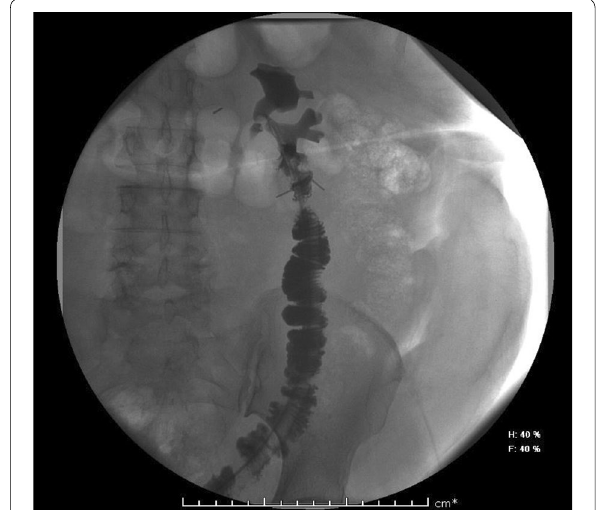
Fig. 1 Post-operative retrograde nephrostogram following ileocalicostomy for proximal ureteric